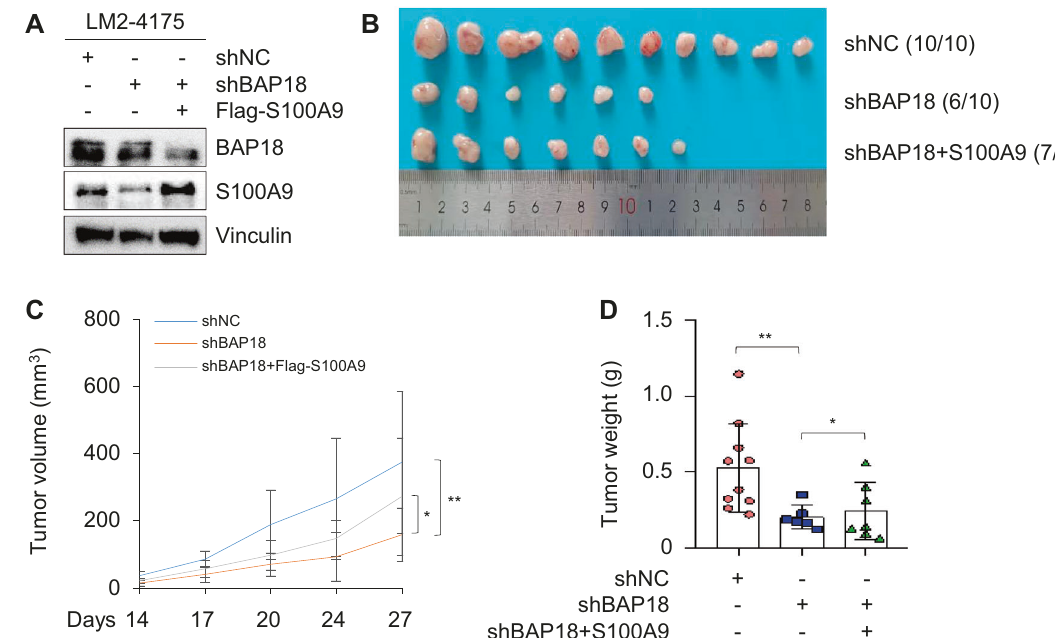
Fig. 7 BAP18 promotes TNBC tumor growth partially through transcriptional transaction of S100A9. A Validation of BAP18 and S100A9 in LM2-4175 cells stably expressing shNC, shBAP18 alone or in combination with Flag-S100A9 by immunoblotting. B − D LM2-4175 cells (1 × 10 6 ) stably expressing shNC, shBAP18 alone or in combination with Flag-S100A9 were subcutaneously injected into the mammary fat pads of 6- week-old female BALB/c nude mice ( n = 10). After 4 weeks of injection, xenograft tumors were removed from nude mice and photographed ( B ). Tumor volume and weight of xenograft tumors are shown in C and D , respectively. * p < 0.05; ** p <